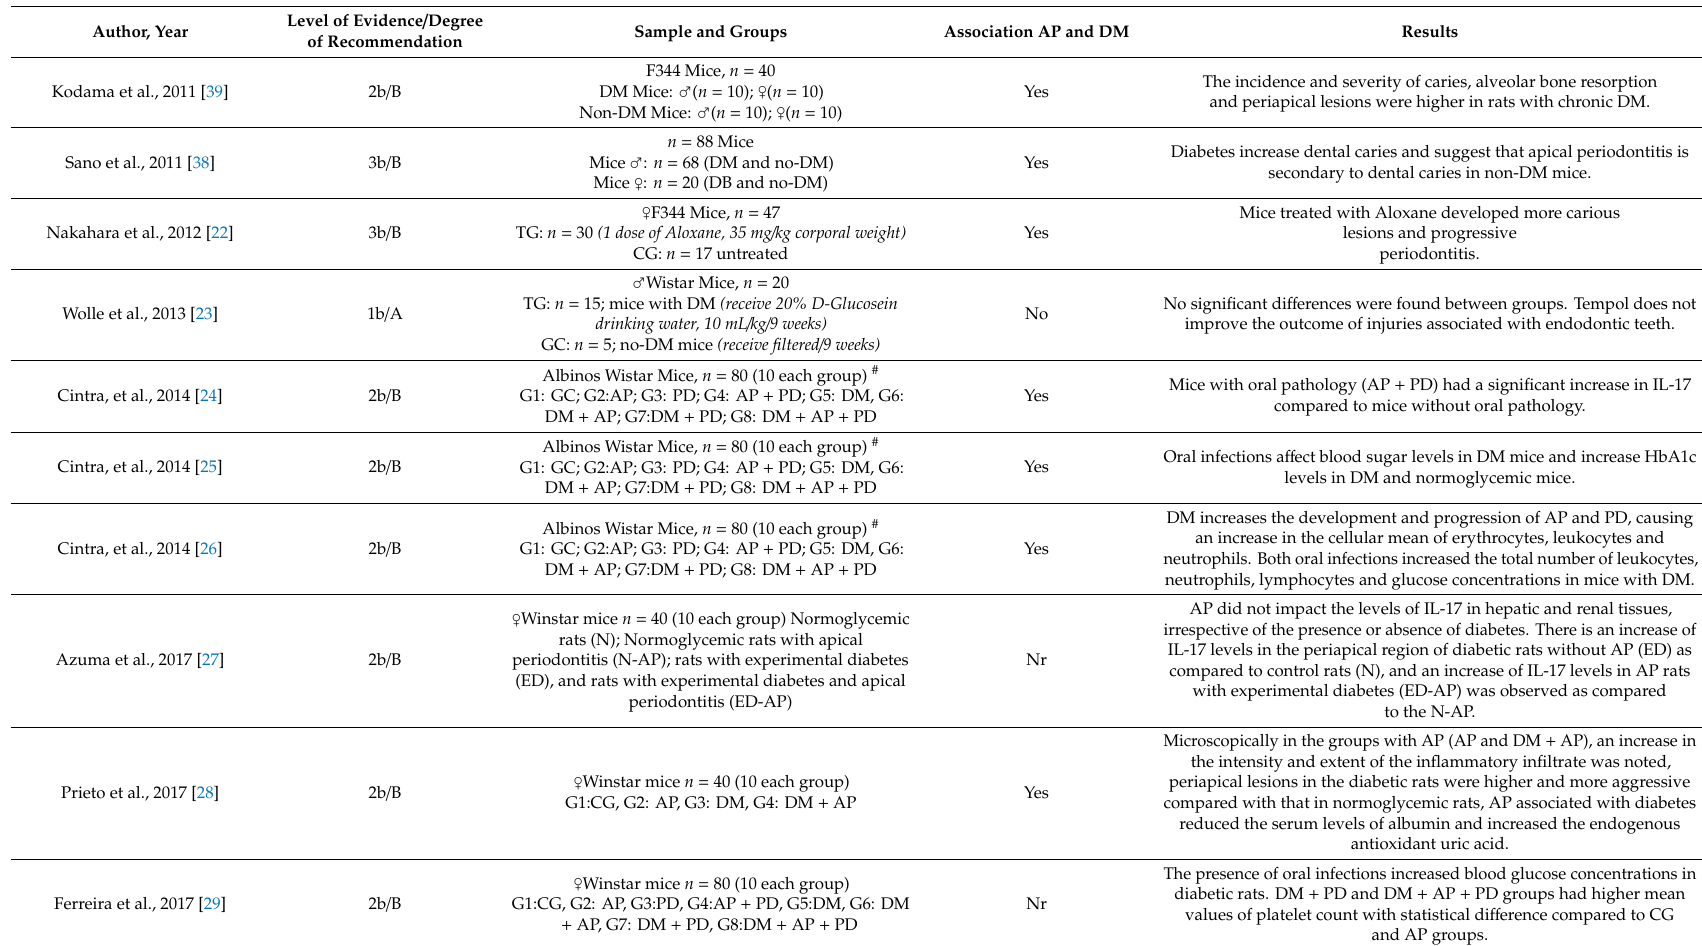
Table 1. Main features of animal studies included on the